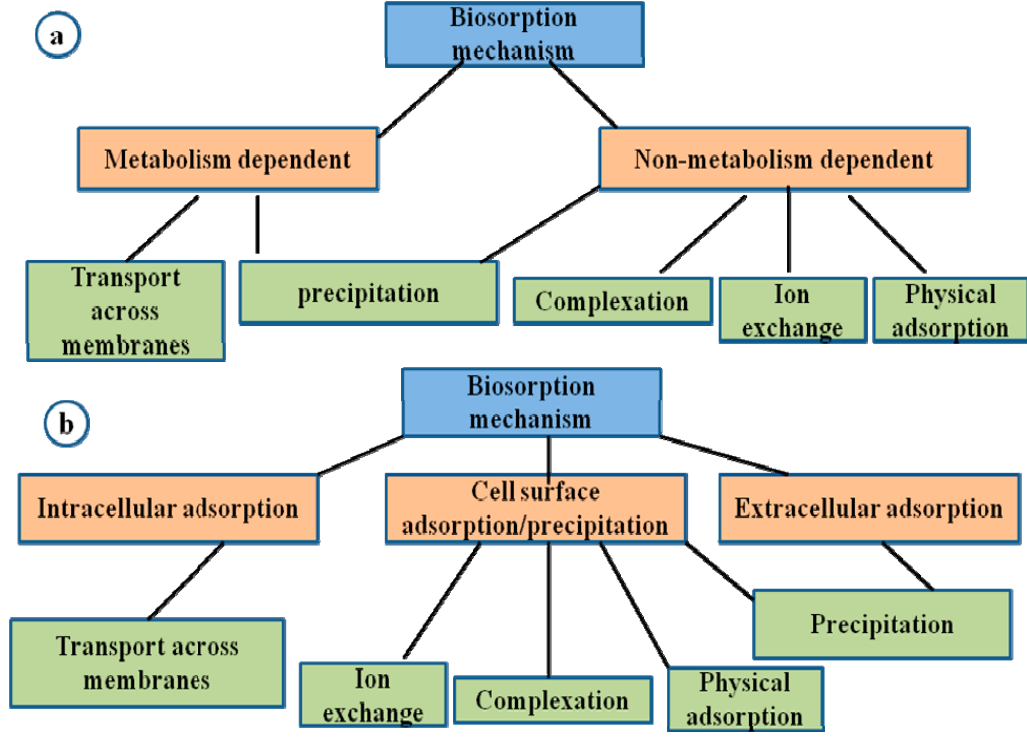
Figure 2. Mechanisms of biosorption based on ( a ) dependence on cell metabolism; ( b ) location within the cell where the metal is removed, adapted from Gupta et al. [43]. In the figure the top is figure a and bottom figure b and the last green boxes on the right top and bottom is physical adsorption. The boxes need to be expanded.